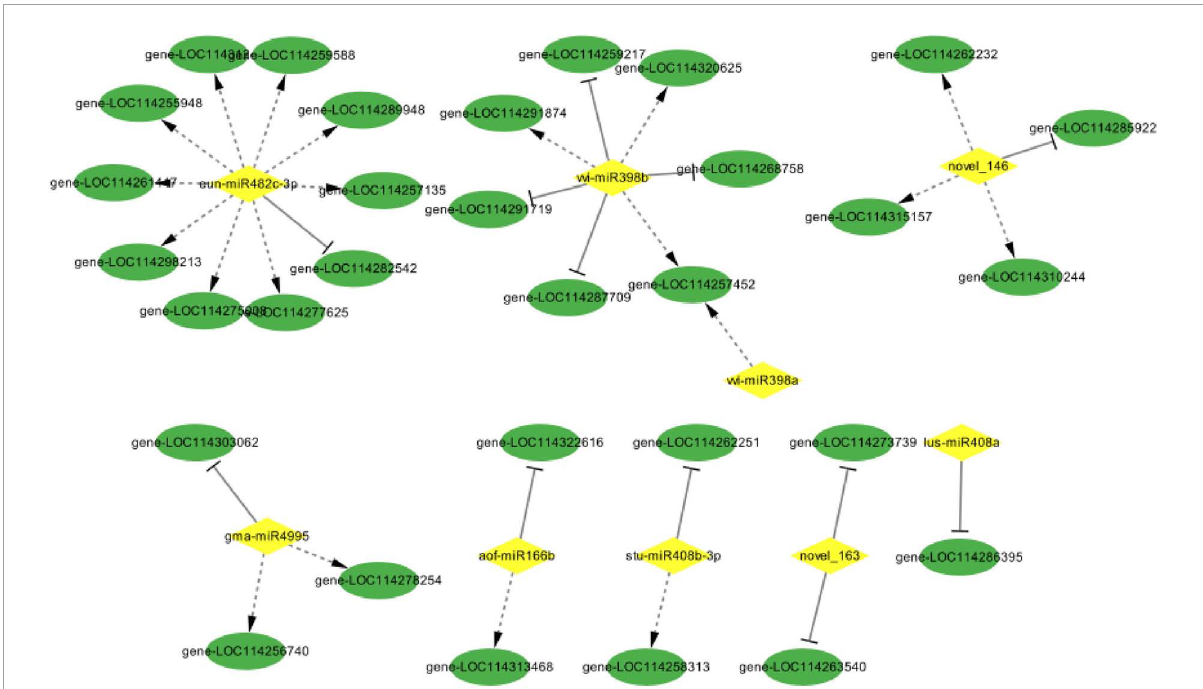
FIGURE12 miRNA-mRNA regulatory network involved in the response to drought stress. The network of differentially expressed miRNAs and the predicted target genes was shown, and the negative and positive correlations between DEMs and their target were reflected by the solid line with a stop symbol and dotted line with an arrow, respectively.